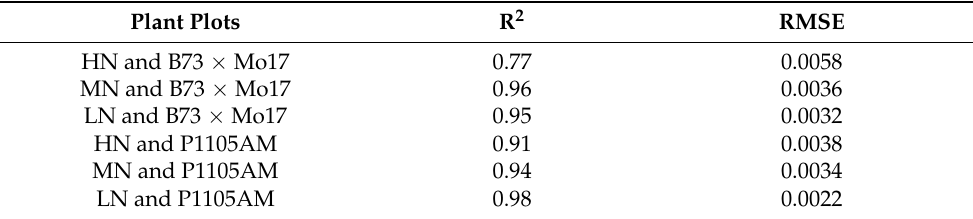
Table 6. Fit and error of the piecewise NDVI diurnal changing pattern model (Equation (8)) on assorted experiment plots.